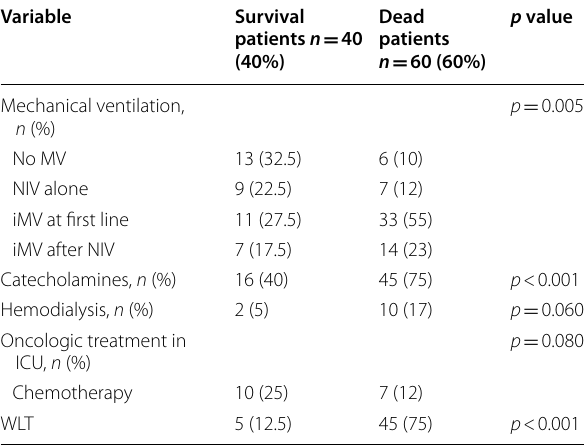
Table 3 Univariate analysis of ICU’s interventions associated with hospital mortality